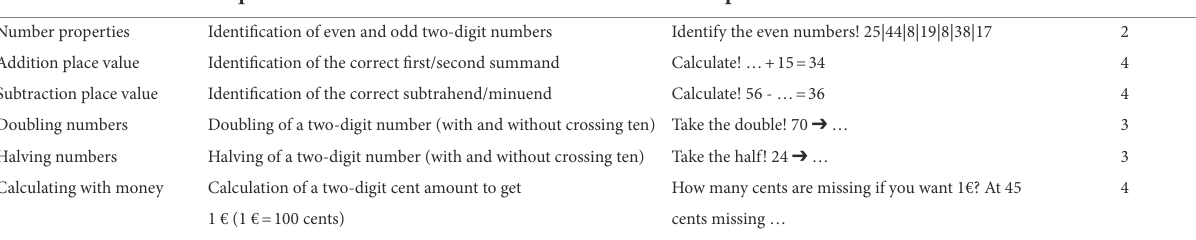
TABLE 2 Subscales of the DEMAT 2+ (Krajewski et al., 2020) used for this study. Subscale DEMAT 2+ Requirement